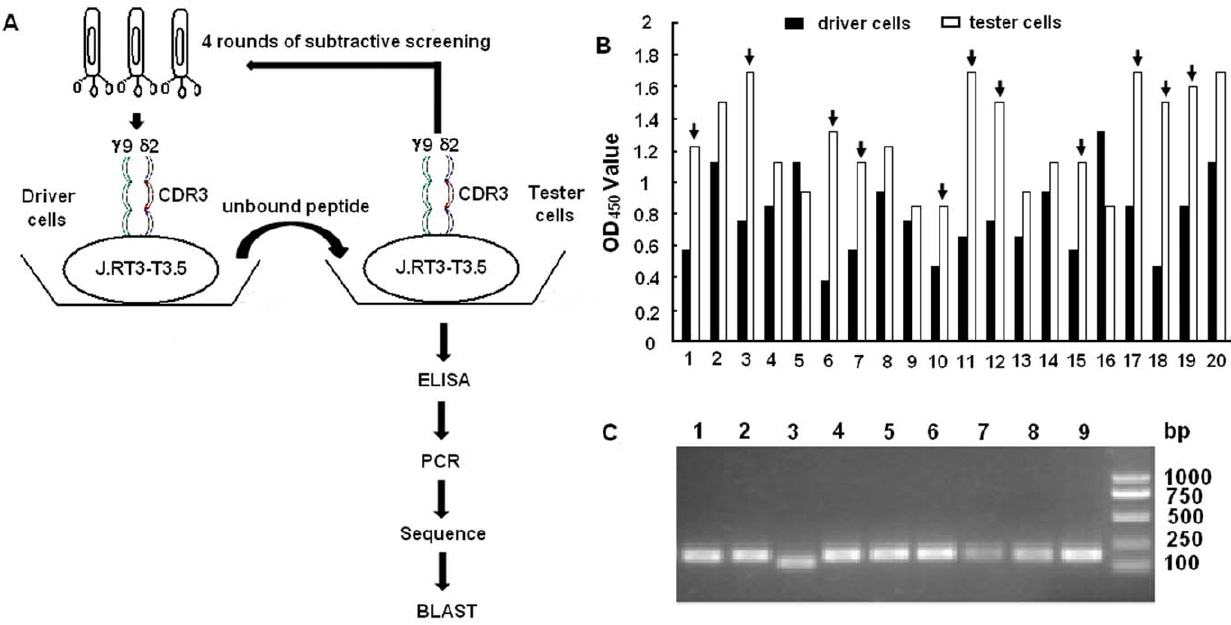
Figure 2. Biopanning of BCG specific cd TCR recognized peptides from phage library using the transfected cells. (A) The flow chart about screening and analysis of the peptides recognized by BCG specific cd TCR. (B) Selection of BCG specific cd TCR recognized positive phage clones by phage-ELISA. Representative data are shown in this figure. Dark arrow pointed bars represent the ratio of specific binding to nonspecific binding was more than 2, and corresponding phage clones were taken as positive clones. (C) Confirmation of BCG specific cd TCR recognized positive clones by RT-PCR. The BCG specific cd TCR recognized peptides were rescued by RT-PCR using phage specific primer provided in kit. 9 individual representative clones are shown in this figure. The RT-PCR products of positive clones were sequenced using specific sequencing primer. doi:10.1371/journal.pone.0018809.g002 results are listed in Table 3. The peptide BP3 had the best matching characteristics to protein in Mycobacterium , with an E value of 39.2. The matching protein of BP3 was oxidative stress response regulatory protein (OXYS) in M. tuberculosis K85 , M.